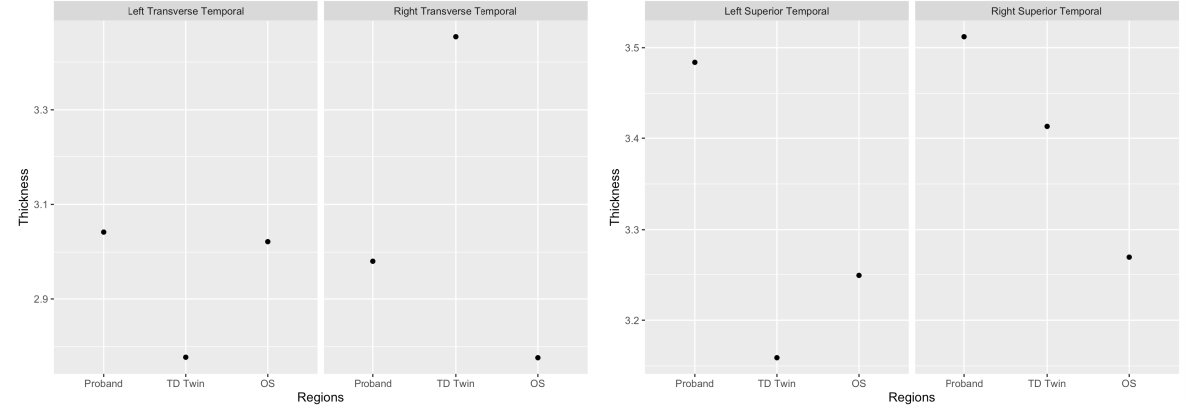
the left hemisphere may have been a greater driver of the asymmetry pattern in the supe- rior temporal gyrus.